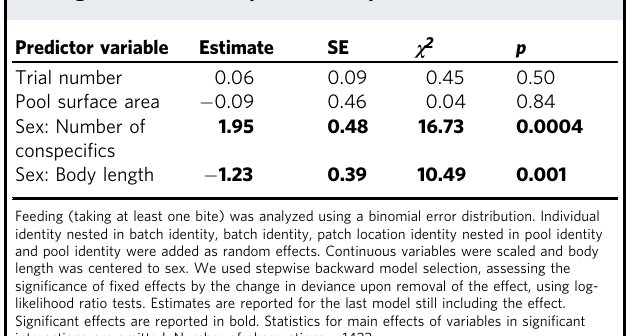
Table 3 Generalized linear mixed model summary for feeding at a novel food patch while